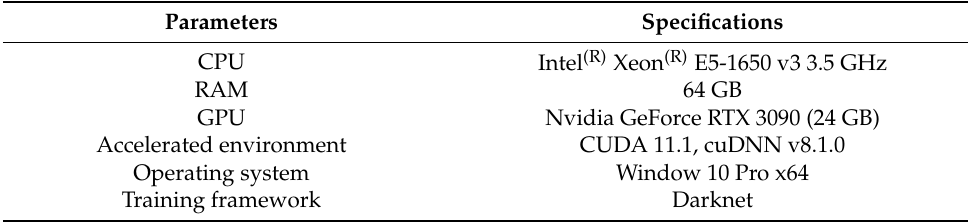
Table 6. Experimental